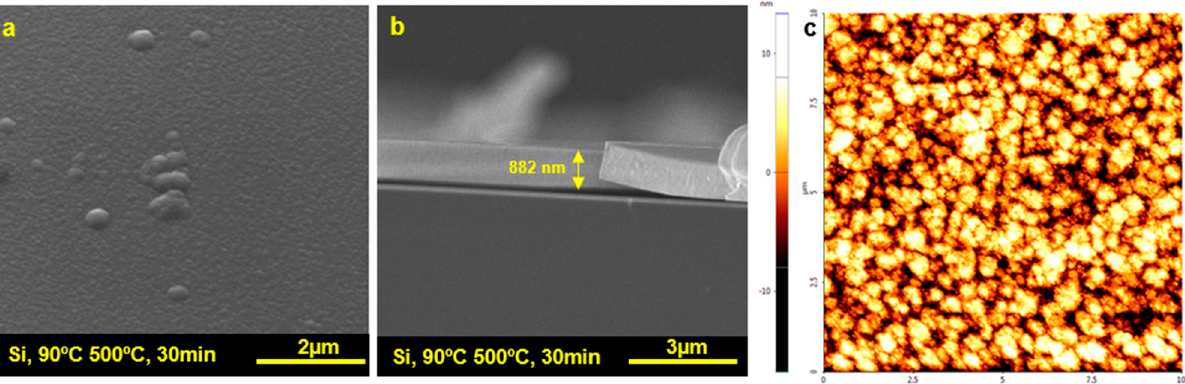
Figure 7. Representative ( a ) SEM image, ( b ) cross − sectional SEM image, ( c ) AFM image of thin films deposited using 4a as precursor in a CVD process.